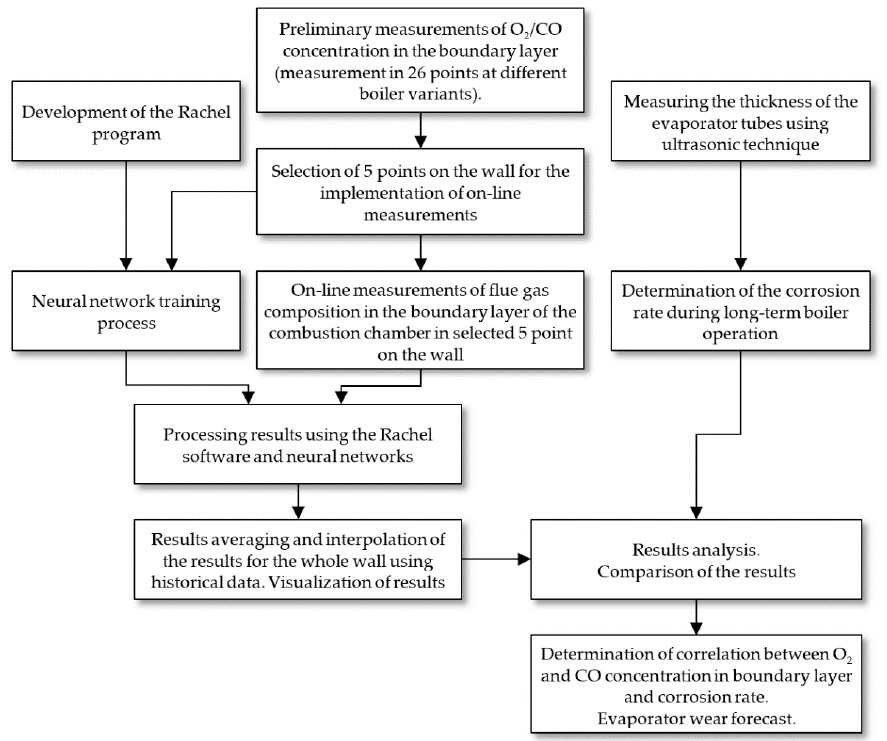
Figure 13. The diagram of the testing procedure to determine the correlation between flue gas composition and the corrosion rate of the evaporator.